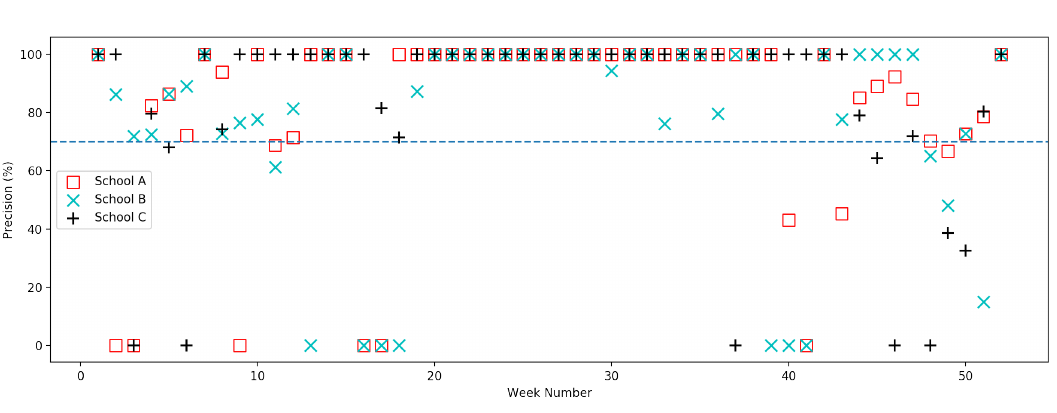
Figure 16. The precision of anomaly detection result for three schools’ weekly data of the year